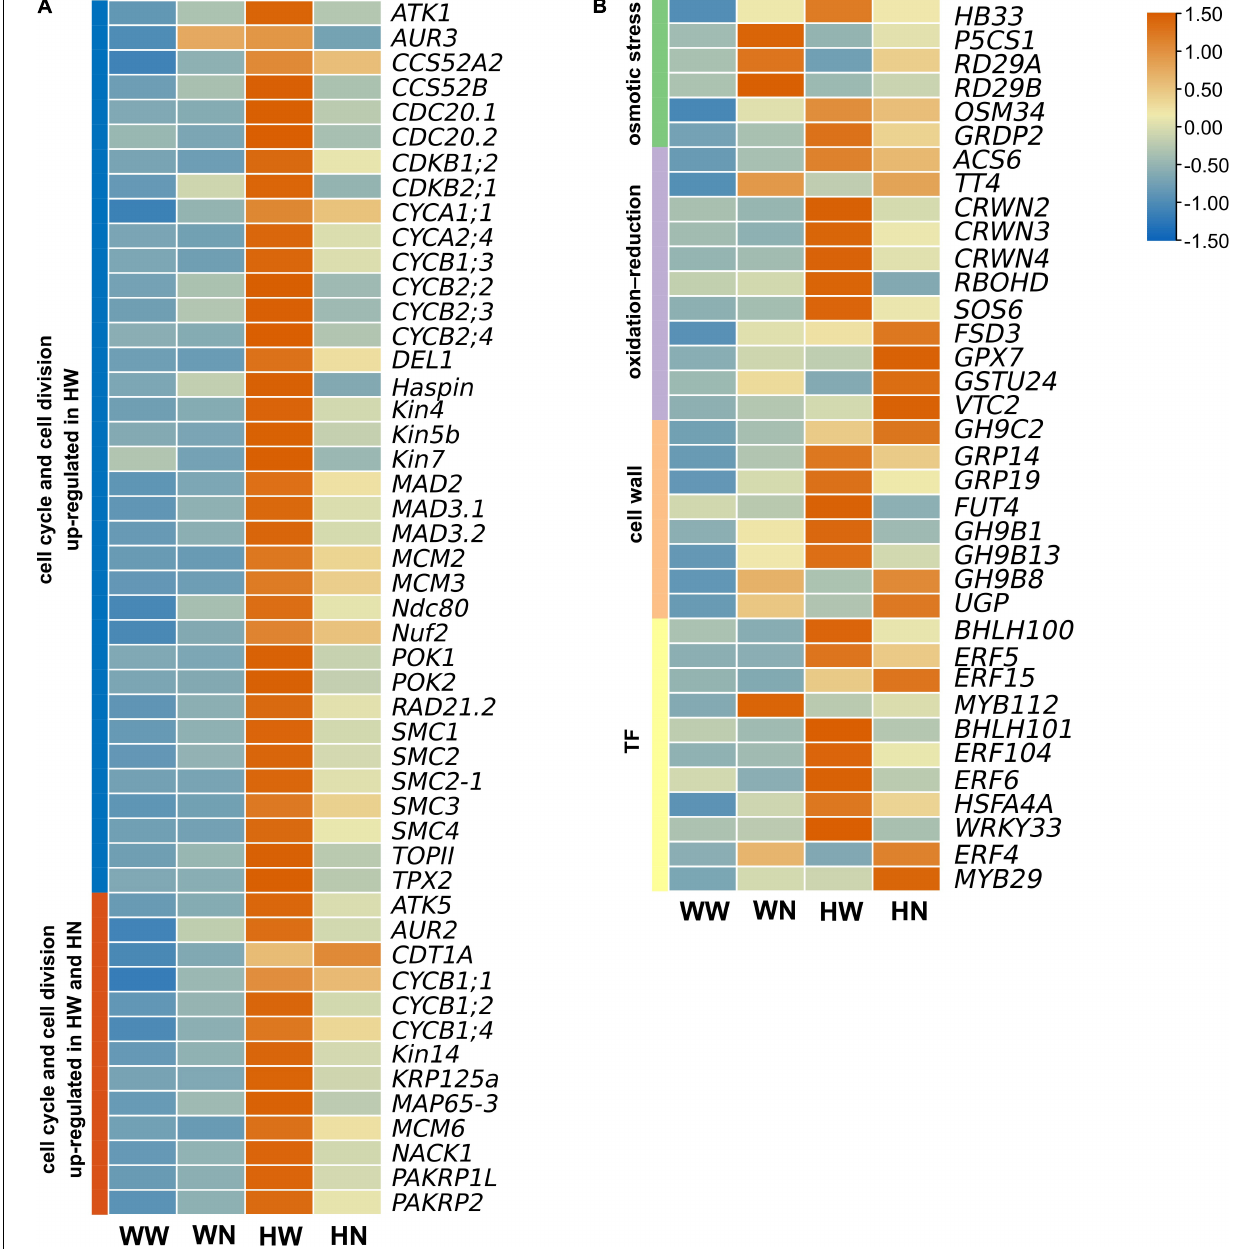
Frontiers in Plant Science |